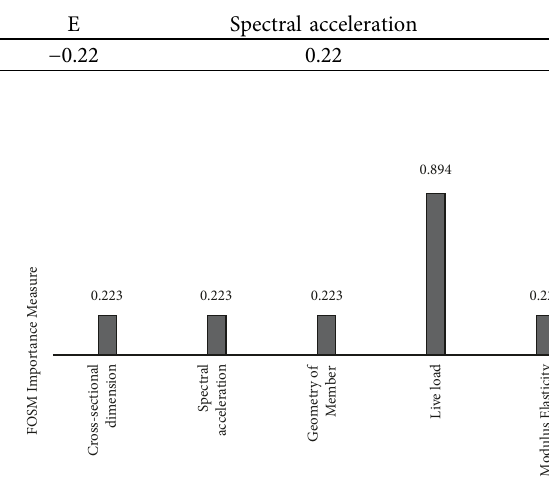
Table 3: Results of the significance of uncertainties scale in FOSM analysis of type I headed frames. Uncertainty